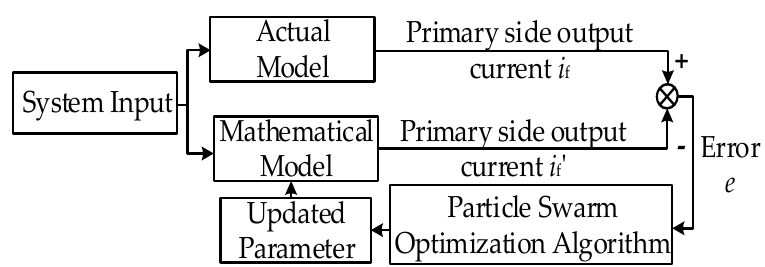
Figure 4. The schematic diagram of system parameter identification. Particle Swarm Optimization (PSO) is a search algorithm to find the optimal solution through collaboration and information sharing among individuals in a population which is used in this paper. Compared with the traditional algorithm, it has the advantages of being easy to implement with a few adjustment parameters, but due to its tendency to fall into local optimum, time-varying weight coefficients are introduced. This coefficient can adjust the balance of global and local search ability well for different search problems. The specific implementation flow of the algorithm is shown in Figure 5.